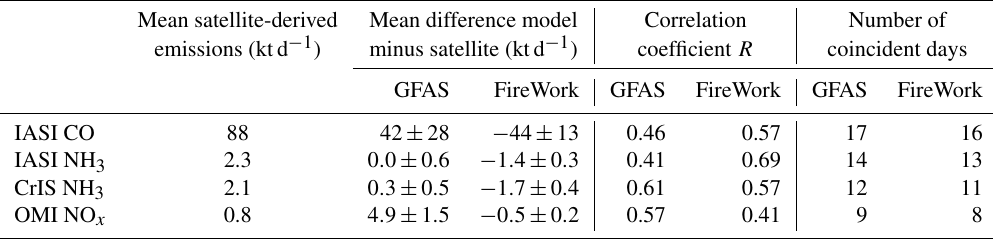
Table 2. Comparison statistics for emission estimates from satellite versus models. Uncertainty in the mean difference is the standard error. Mean